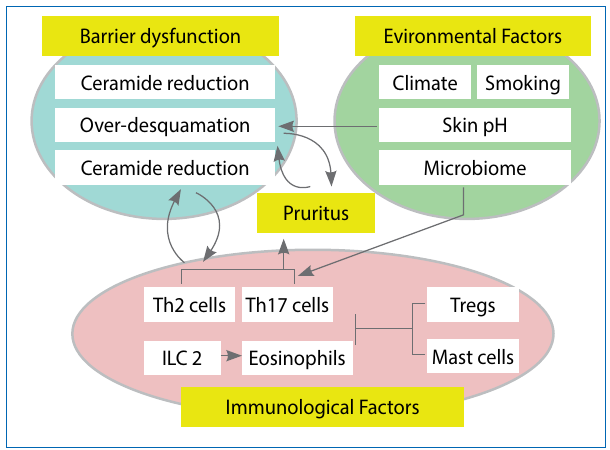
Figure 6. Interplay among contributing factors 15